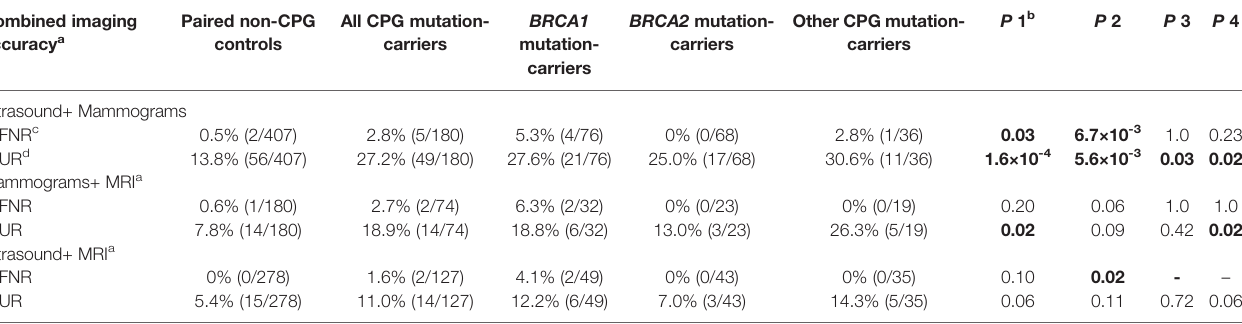
TABLE 3 | The performance of combined imaging modalities in patients with cancer predisposition gene mutations and pair non-mutation controls. Combined imaging accuracy